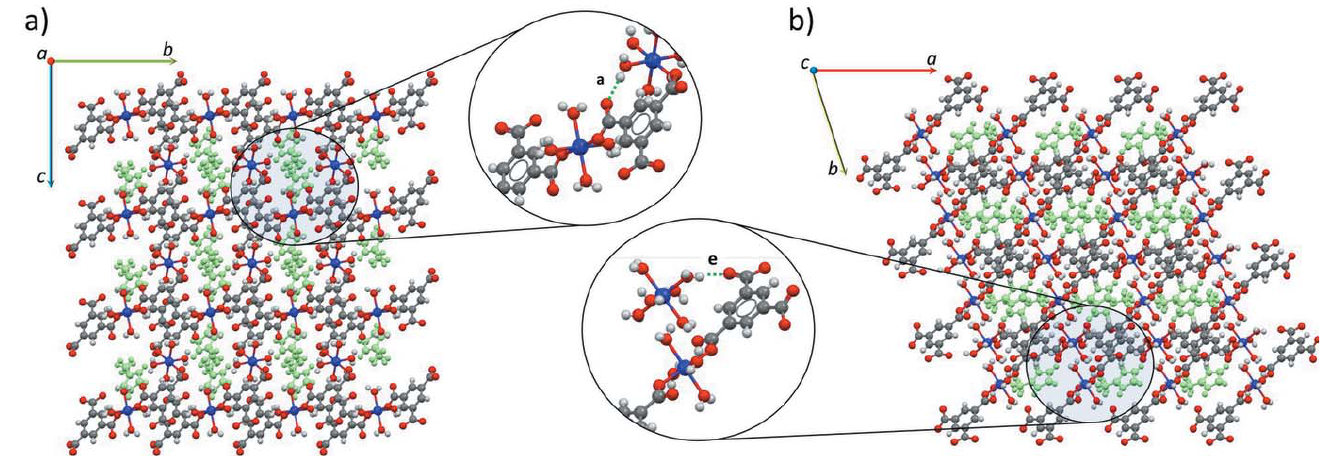
Figure 3 The three-dimensional supramolecular network with one-dimensional channels along the ( a ) a and ( b ) c axes showing O—H (cid:5)(cid:5)(cid:5) O hydrogen bonds of type a and e in the magnified area. Imidazolium ions are drawn in green for